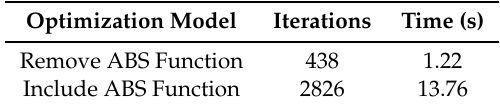
Table 6. Computation time for solving the optimization model.